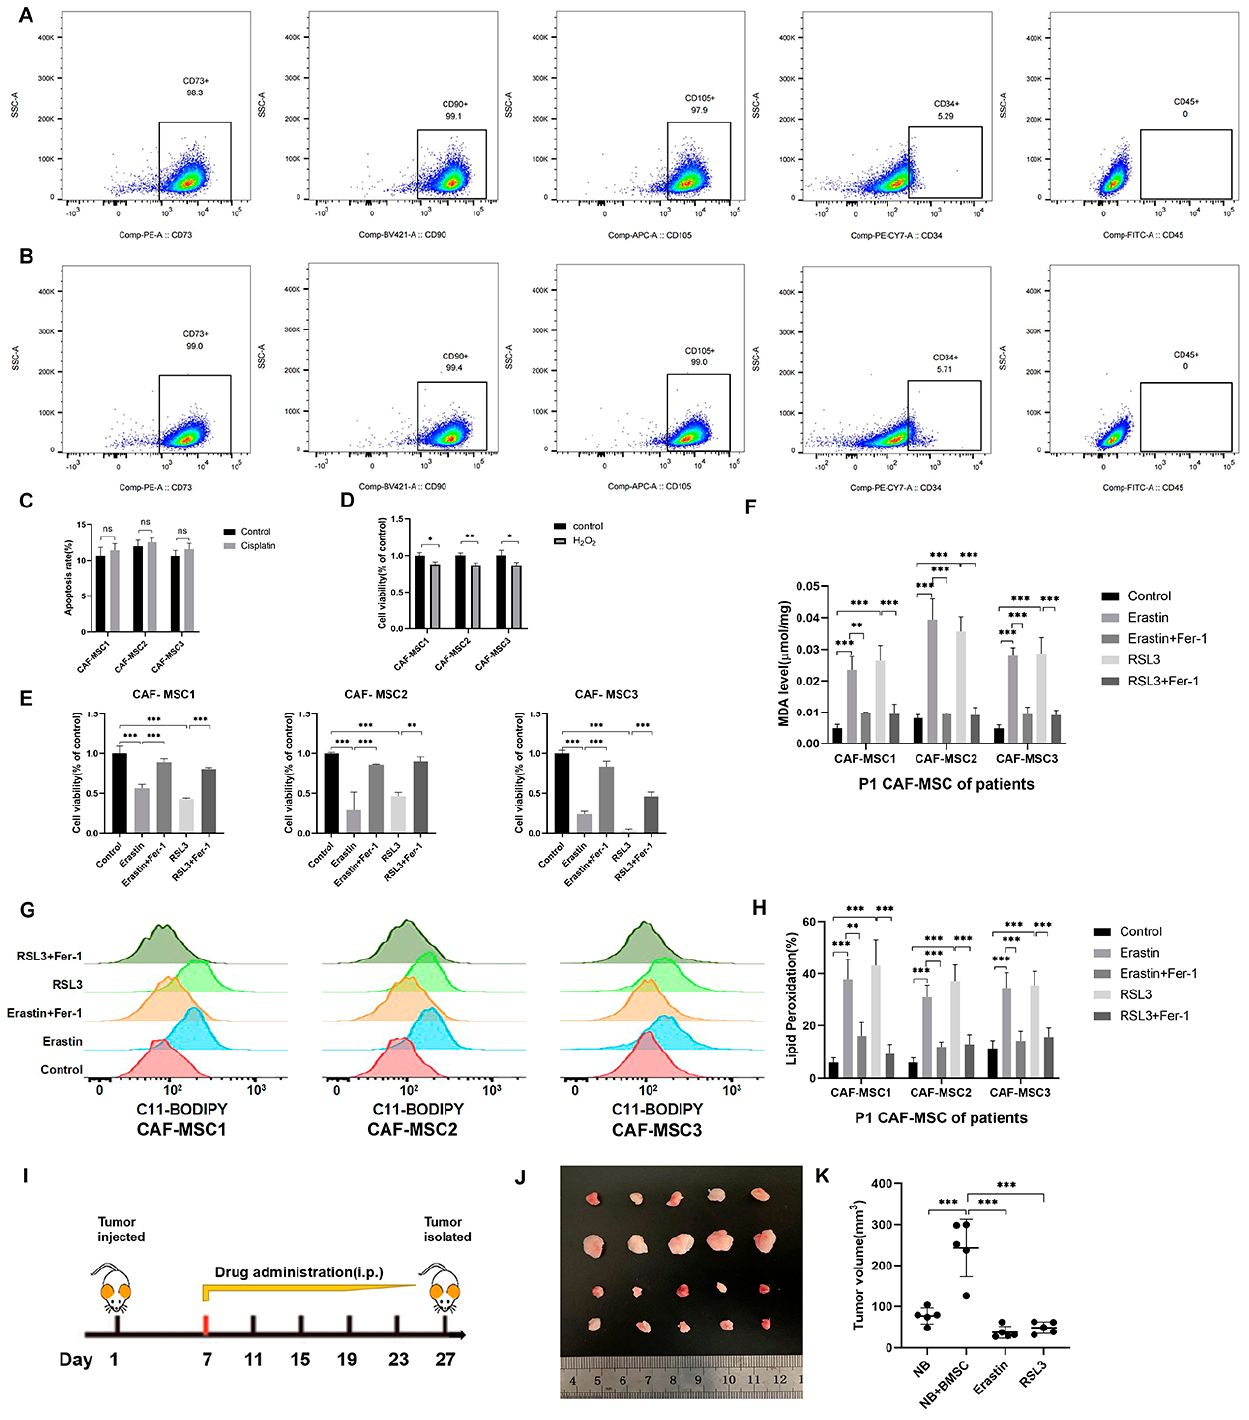
Figure 6. CAF-MSCs of NB patients and mouse model supported our viewpoint. ( A , B ) FACS analysis for detecting surface markers of NB-BMSCs and CAF-MSCs of NB patients. ( C ) Apoptosis rate of CAF-MSCs from NB patients was examined under 10 μ M cisplatin. ( D ) Cell viability of CAF-MSCs was detected under 400 μ M H 2 O 2 . ( E – H ) Cell viability, MDA level, and lipid peroxidation level were detected to reflect the ferroptosis level under 4 μ M erastin and 2 μ M RSL3. ( I – K ) Mouse modelling was conducted and tumor progression was observed. Student’s t -test was used in analysis of ( C , D ), while a one-way analysis of variance was used in other analysis. ns not significant; * p < 0.05; ** p < 0.01; *** p < 0.001.